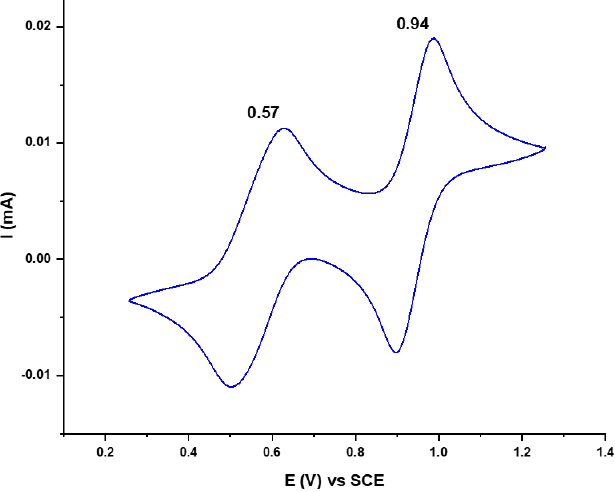
Figure 4. Cyclic voltammogram of ( rac )- 1 in 0.1 M Bu 4 NPF 6 /CH 2 Cl 2 , Pt electrode, scan rate 100 mV s −1 . The E 1/2 values are shown for both reversible peaks. 100 mV s − 1 . The E 1/2 values are shown for both reversible